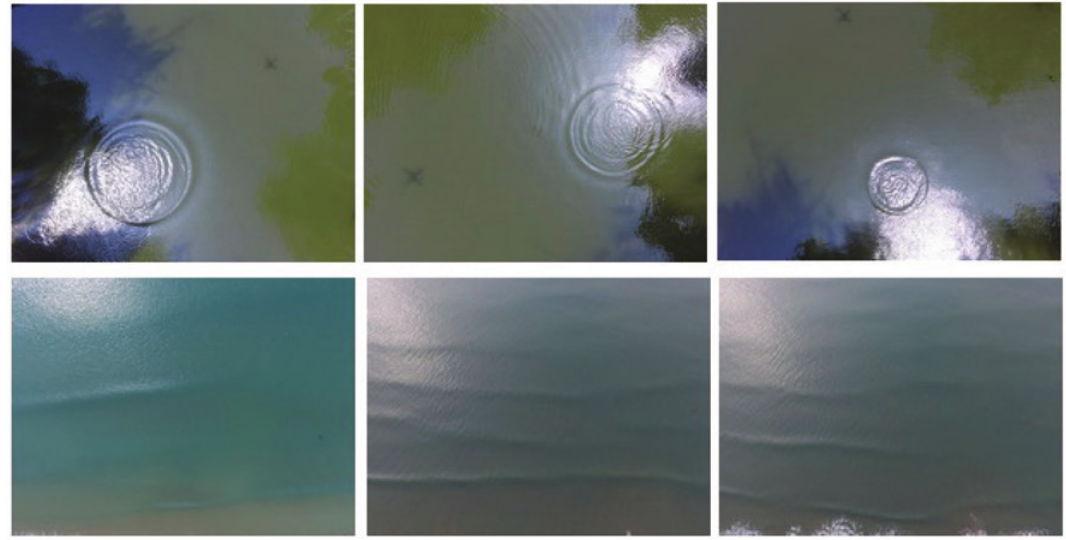
Figure 4: Image samples of our data set. First row represents simulative wave images, while second row represents the inshore surge wave